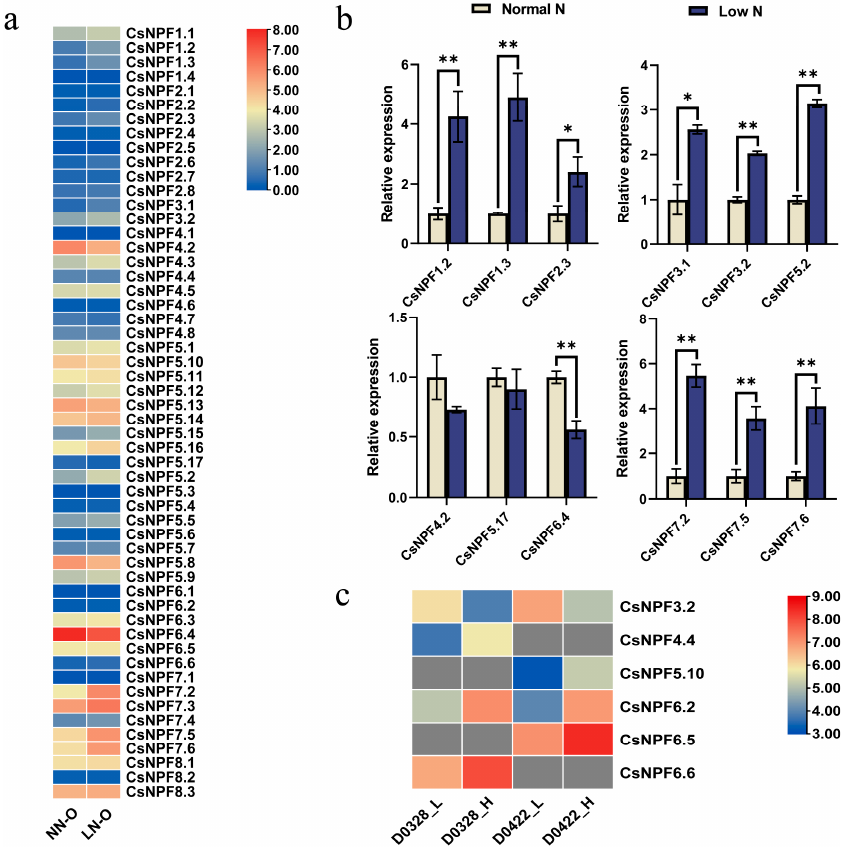
Figure 8. Expression profiles of CsNPF genes under different N treatments. ( a ) The expression patterns of 54 CsNPF genes under N deficiency treatments in cucumber roots. The expression data were obtained from RNA-seq data and are shown as log2 − transformed FPKM values. NN-O, normal nitrogen treatments; LN-O, N deficiency treatments. ( b ) Relative expression levels of 12 CsNPF genes under N deficiency treatments using qRT–PCR in roots. A significant difference between the different treatments was indicated by Tukey’s method (* p < 0.05, ** p < 0.01). Data from cucumber roots treated with normal nitrogen were selected as standards, to measure the relative expression of genes in other nitrogen treatments, and the expression levels of each gene under normal nitrogen treatment was set as 1. ( c ) Differentially expressed CsNPF genes identified from D0328 and D0422 plants grown under low and high N conditions. D0328_L, D0328 grown under low N conditions; D0328_H, D0328 grown under high N conditions; D0422_L, D0422 grown under low N conditions; D0422_H, D0422 grown under high N